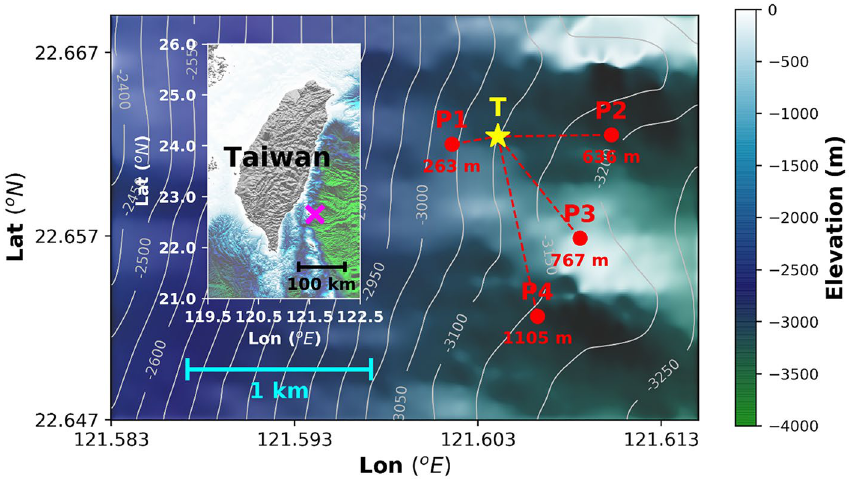
Figure 1. Location of the experimental site. A multi-instrument array within a 1 × 1 km footprint (magenta cross in insert) was deployed on continental slopes offshore eastern Taiwan. The array has a 200-m long vertical thermistor string (T-string, yellow star) with a Nortek AquaDopp acoustic current meter at 2936 m, and four Cox-Webb differential pressure gauges (DPG P1, P2, P3 and P4, red dots) attached to four broadband ocean bottom seismometers. Dashed red lines and numbers below the red dot show the shortest horizontal distances (with error ± 10 m) from the T-string to each DPG. Bathymetric maps with depths in [m] were made using the Matplotlib graphic tool (version 2.1.2; URL: matplotlib.org) for Python using 100 × 100 m resolution interpolated bathymetry data from a multibeam